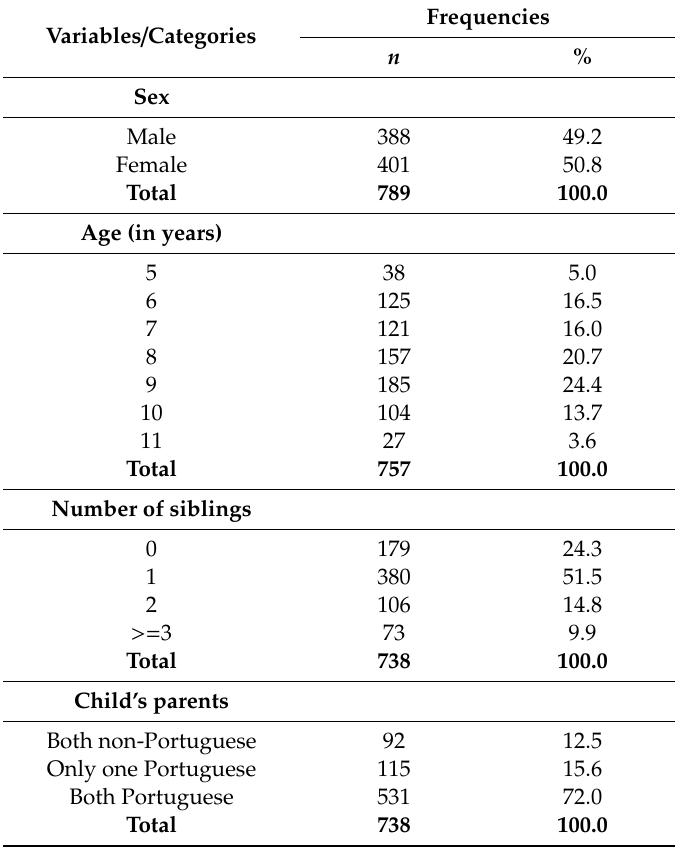
Table 2. Sociodemographic characteristics of children and origins of their